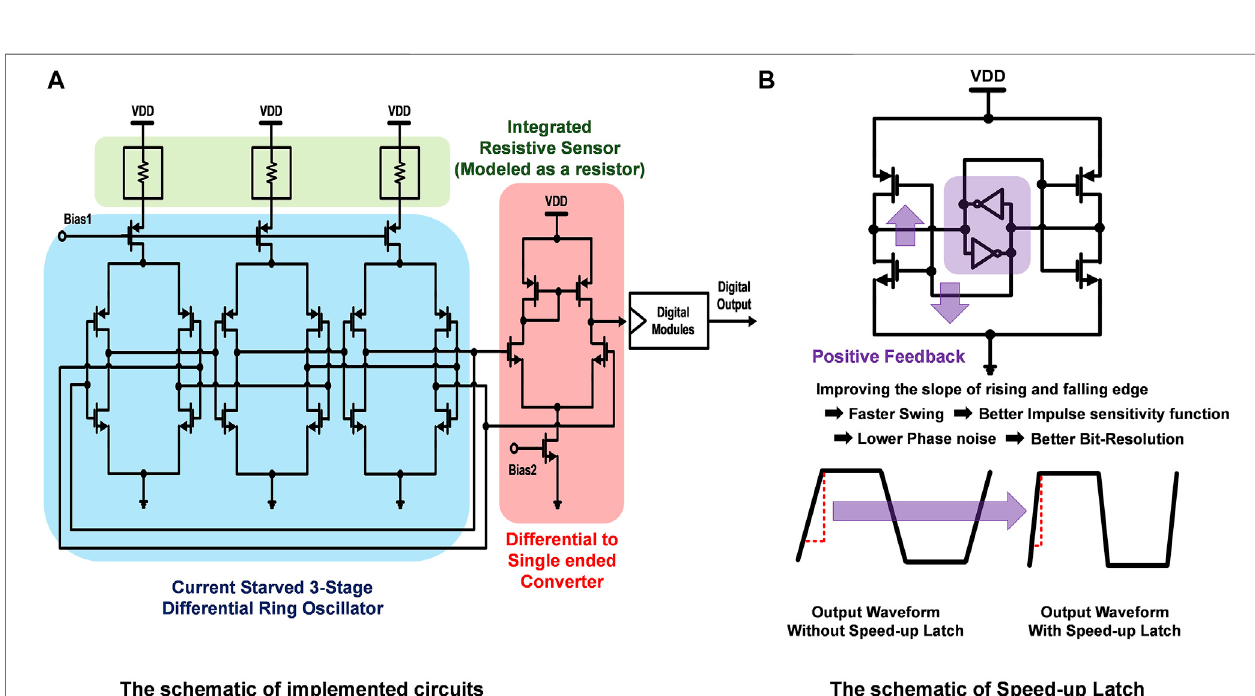
FIGURE 4 | Implemented circuit schematic: (A) a resistive sensor, a current-starved three-stage differential ring oscillator, and a differential-to-singled-ended ampli fi er and (B) improving the slope of rising and falling edge of a three-stage ring oscillator using the speed-up latch.